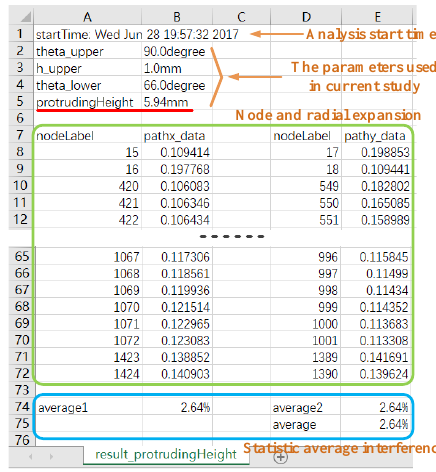
Figure 7. The data format saved in Excel files.